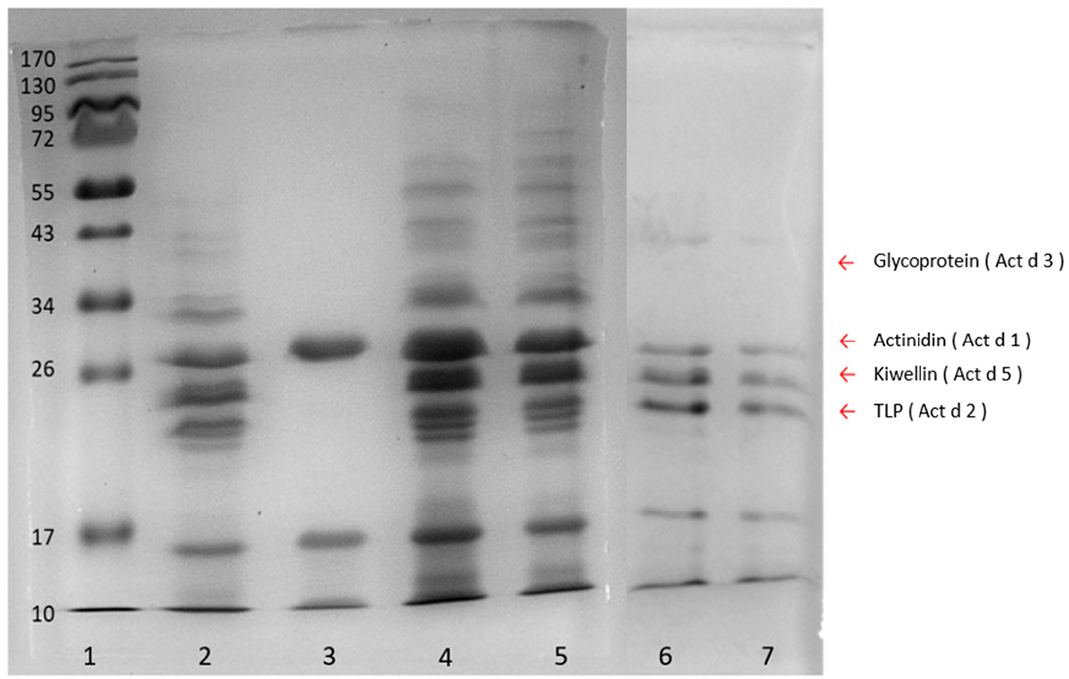
Figure 2. SDS-PAGE of the kiwifruit extracts from four different protein extraction methods. Lane 1, protein ladder; lane 2, phenol method; lane 3, ammonium sulfate method; lanes 4 and 5, TCA method; lanes 6 and 7, sodium chloride method. Arrow indicators on the right indicate four indicator proteins, glycoprotein (Act d 3) (40 kDa), actinidin (Act d 1) (30 kDa), kiwellin (Act d 5) (26 kDa), TLP (thaumatin-like protein) (Act d 2) (24 kDa).